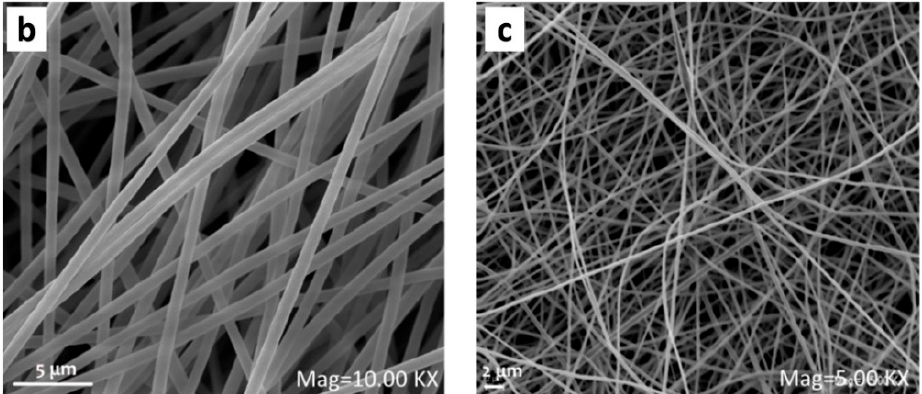
Table 3. XPS data from calcined PAN at different temperatures (heating rate of 1 °C/min, dwell time of 1 h, and Ar atmosphere). Reprinted and adapted with permission from ref. [80]; Copyright 1995, Elsevier Science Ltd. Figure 6. ( a ) The TGA curves of aligned PAN nanofibers (5 °C min − 1 , air) until the targeted oxidation temperature (235, 250, 270, and 300 °C) for a dwell of 6 h (the inset represents the TGA under inert nitrogen atmosphere). SEM images of aligned PAN nanofibers (stabilization at 250 °C for 3 h in air atmosphere and carbonization at 900 °C for 1 h under nitrogen atmosphere) produced with: ( b ) rotating collector and ( c ) with fixed collector. Reprinted and adapted with permission from ref. [53]; Copyrights 2017, Gergin et al.; licensee Beilstein-Institut.